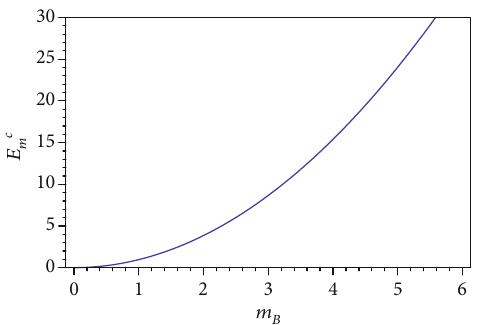
Figure 1: (color online) Variartion of critical color electric fi eld ð critical Þ with m E m B